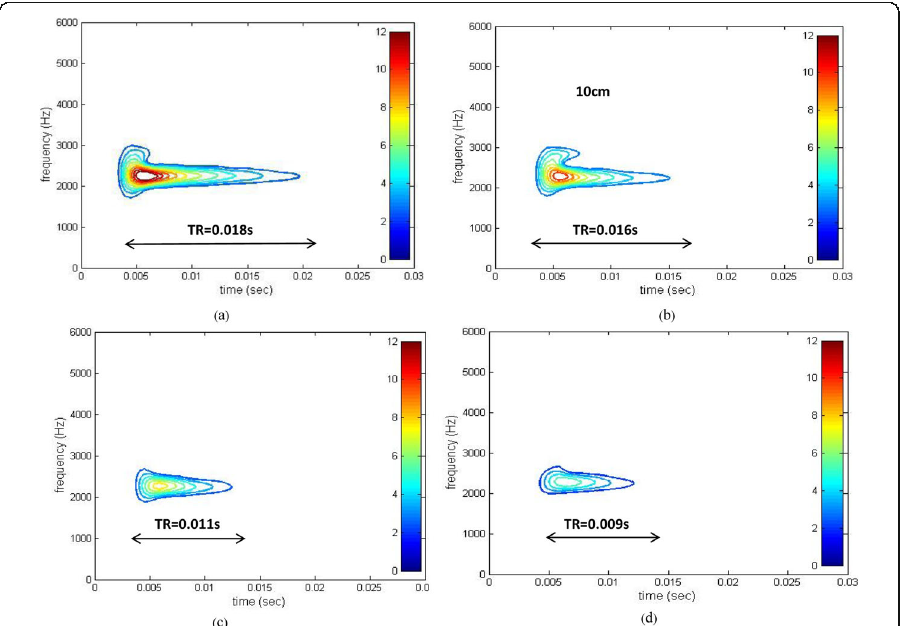
Fig. 17 Case 2: cavity size 5 × 5 × 5cm. a Sensor at 5 cm. b Sensor at 10 cm. c Sensor at 15 cm. d Sensor at 20 cm